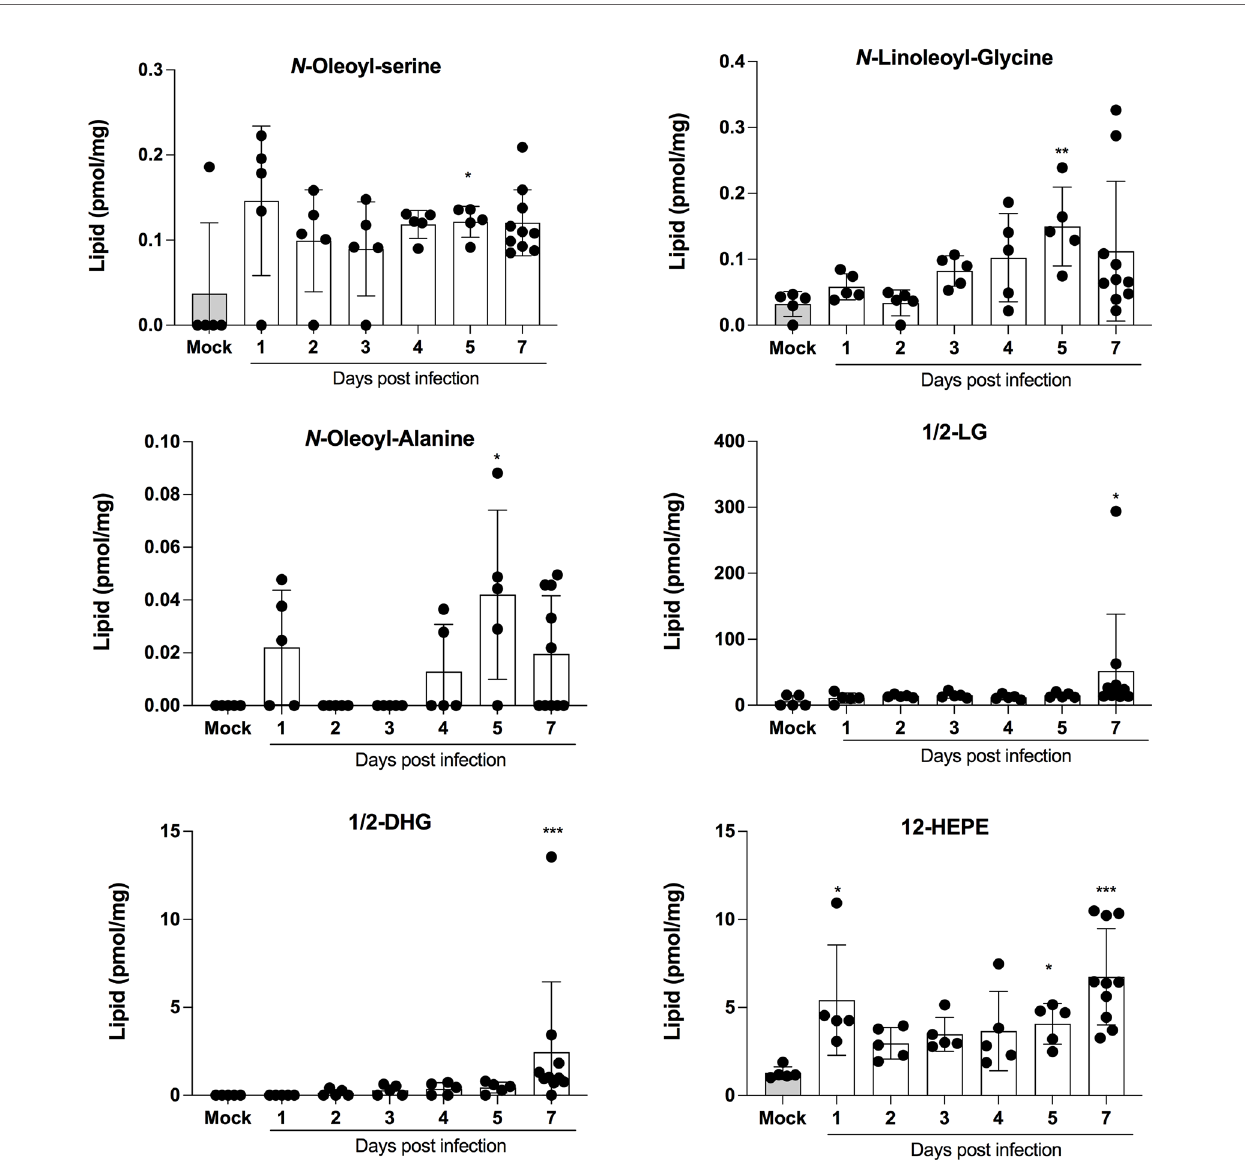
FIGURE 7 | Lipid mediators that are increased in lungs of SARS-CoV-2 infected mice. Lung homogenates corresponding to 10 mg of tissues were heated at 60 ˚ C for 30 minutes in presence of 1 volume of methanol containing deuterated internal standards. Samples then were processed as in Archambault et al (11) to extract the lipid mediators and were analyzed by LC-MS/MS using a previously described analytical method (15). P values were determined using the Kruskall-Wallis test, with p values <0.05 considered statistically signi fi cant. *p<0.05, **p<0.01,